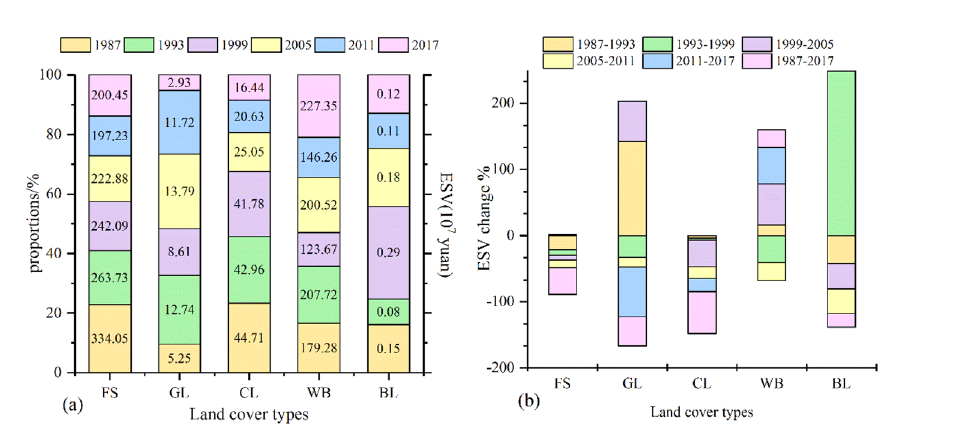
Figure 8. Changes in the total ESV for different land cover types in different